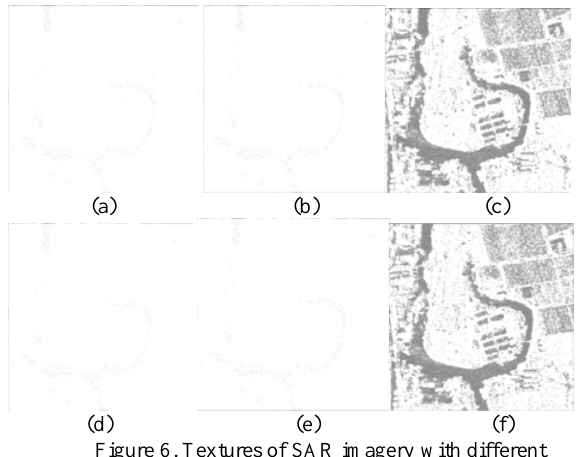
Figure 6. Textures of SAR imagery with different πθ= to πθ= orientations(a to f stand the texture images of 6 π ) with every 6 Figure 9. The transformation results with different m (a, result with m=4; b, result with m=8; c, result with m=16; d,result with m=64)